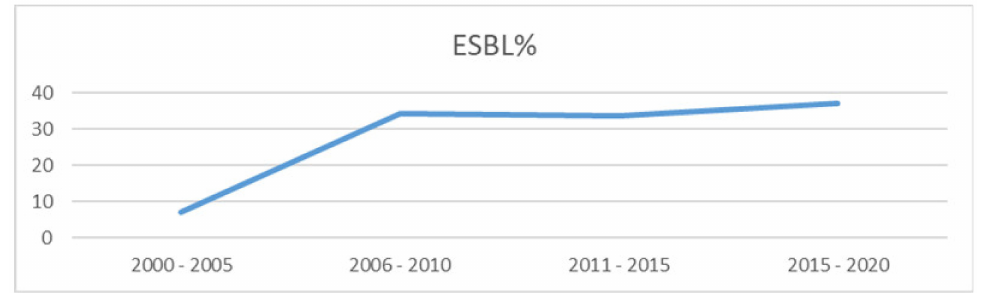
Figure 5. Comparing ESBL producing E. coli and ESKAPE Pathogens during 2000–2020.